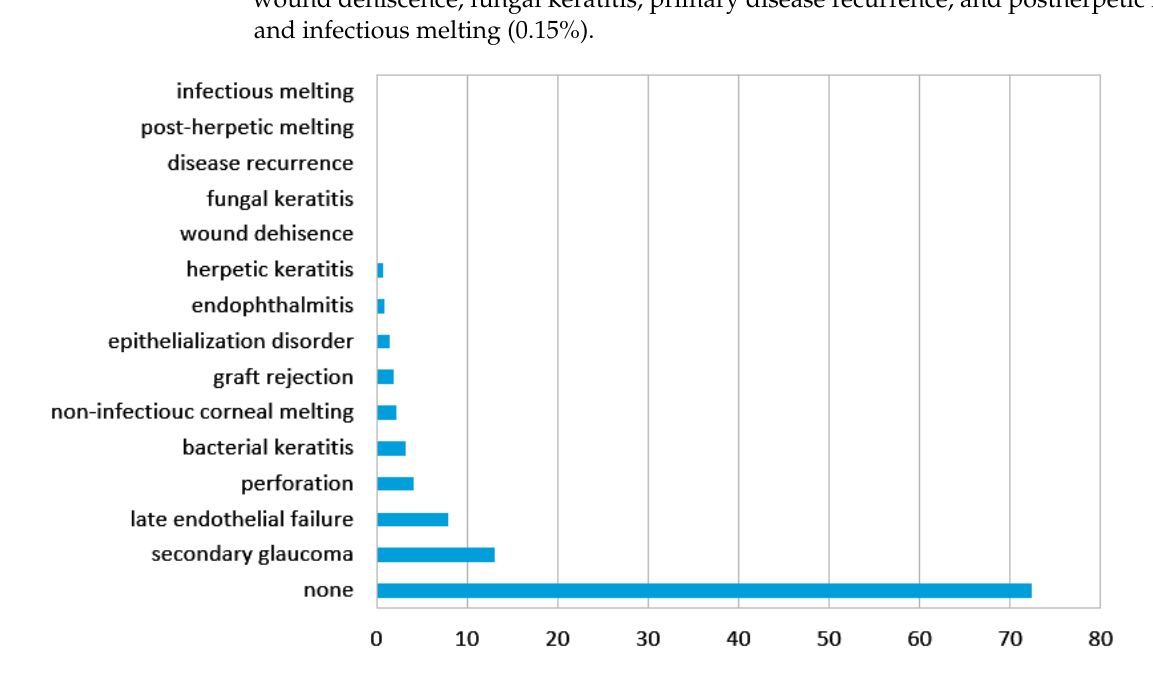
Figure 1. Frequency of corneal graft complications in the analyzed group. The failure rate of PK depended on the complications (Figure 2).